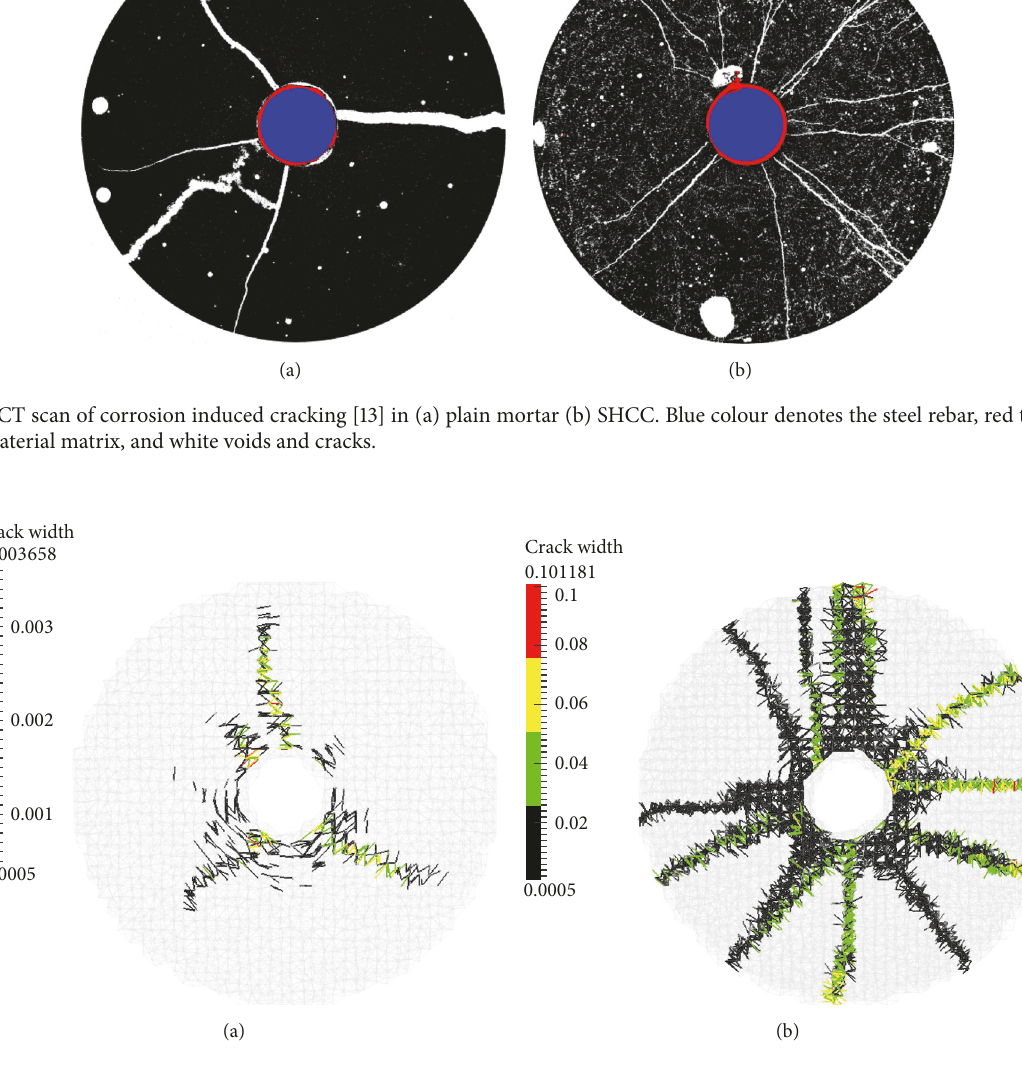
Figure 11: Lattice simulation of corrosion induced cracking of experiments reported in [13] (a) in mortar (imposed internal pressure of 17.32 MPa) and in (b) SHCC (imposed internal pressure of 103.58